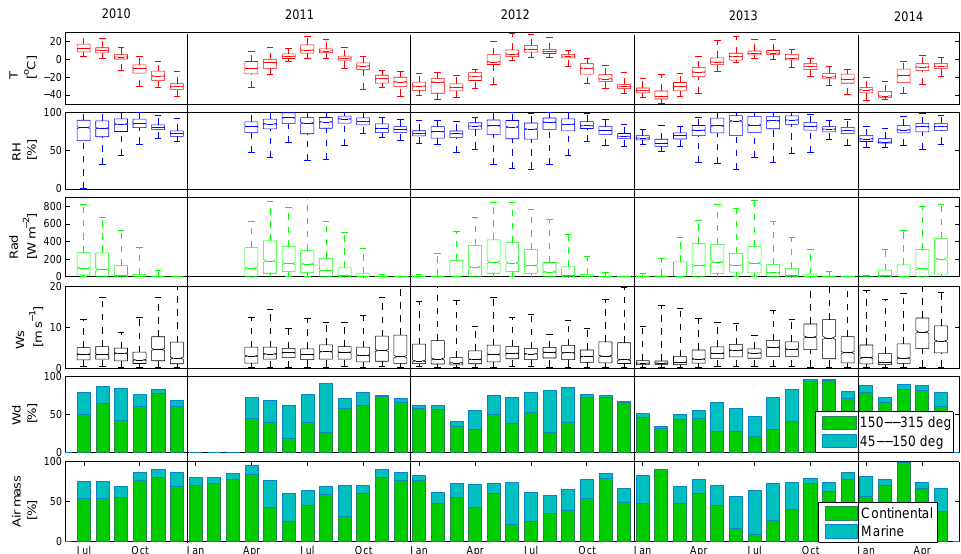
Figure 2. Summary of the meteorological conditions during the measurements. The panels 1–4 (from top to down) depict temperature, relative humidity (RH), global radiation, and wind speed, with bars showing extremes, quartiles and median values for each of the monthly parameters. Wind direction (panel 5) is expressed as percentages from the 45–315 ◦ sector (marine sector) and from the 150–315 ◦ sector (continental sector), leaving out the sector defined as polluted. Air mass origin (panel 6) is presented as percentage of continental ( ≥ 70% during preceding 120h) and marine ( ≥ 70% during preceding 120h) air masses, leaving out the mixed air masses. Also note that RH is expressed as the ratio of the water vapor pressure to the saturation water vapor pressure over water, which is a meteorological convention. In freezing winter conditions, condensation will occur at a lower relative humidity than 100% (over water) when the vapor is saturated over